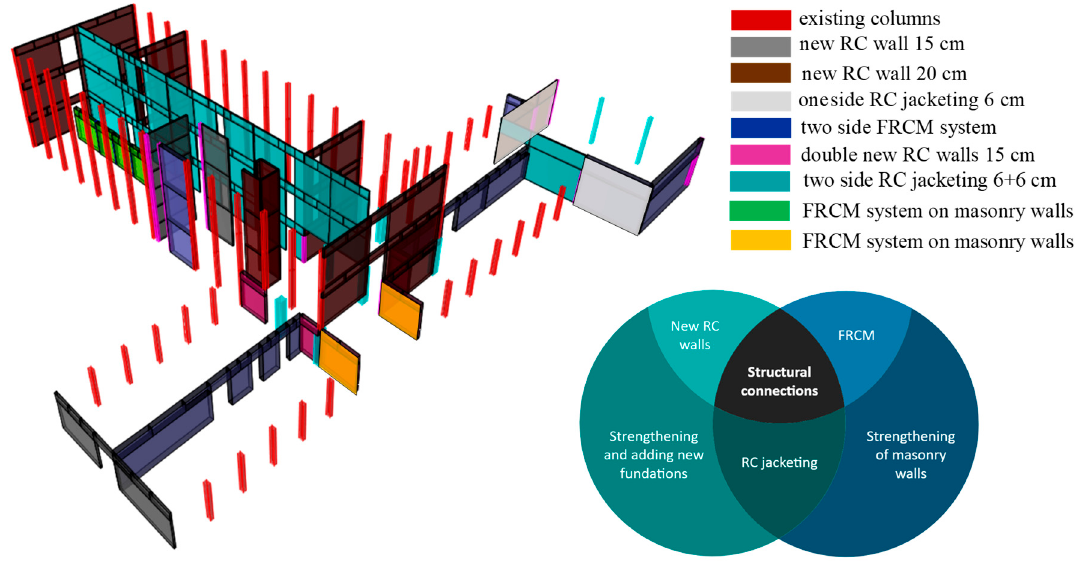
Figure 22. Scheme of strengthening for vertical elements.